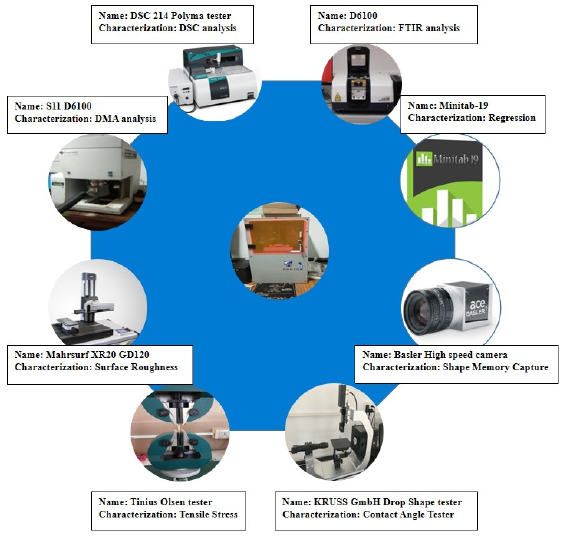
Figure 2. Characterizations performed on the tBA-co-DEGDA resin .